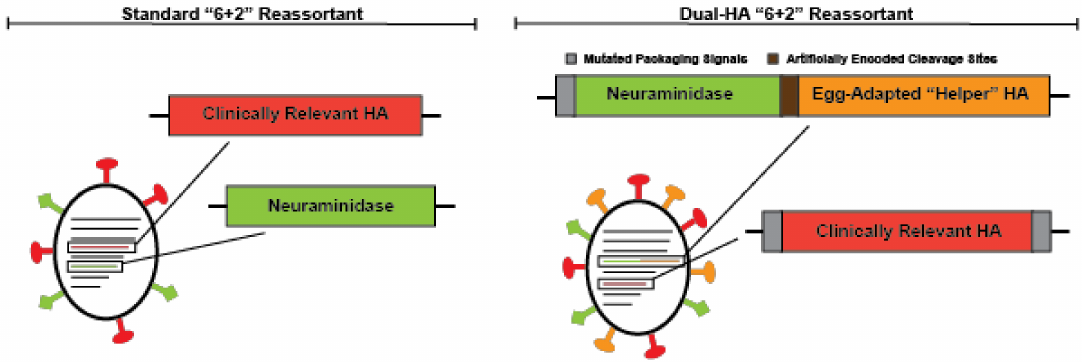
Figure 2. A schematic of the standard “6 + 2” reassortant virus and the dual-hemagglutinin (HA)